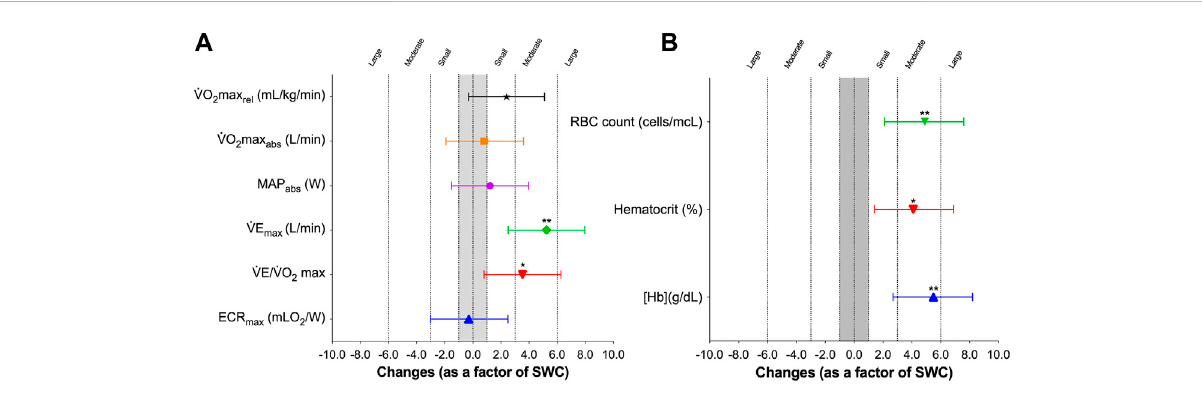
FIGURE 2 Effects of altitude training on maximal values (A) and hematological parameters (B) in elite rowers. SWC: smallest worthwhile change. Differences were calculated as a factor of variable-speci fi c smallest worthwhile differences, where changes of 1×, 3×, 6×, and 10× SWC are considered small, moderate, large, and very large. Symbols and whiskers represent mean ± SD.